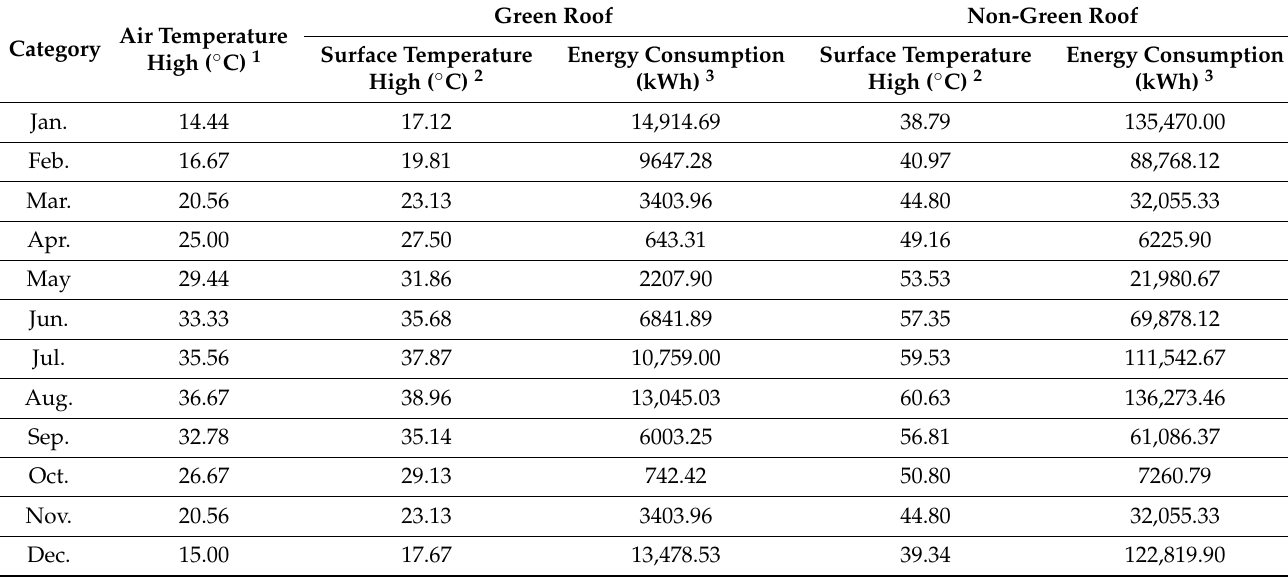
Table 3. Performance comparison of a green